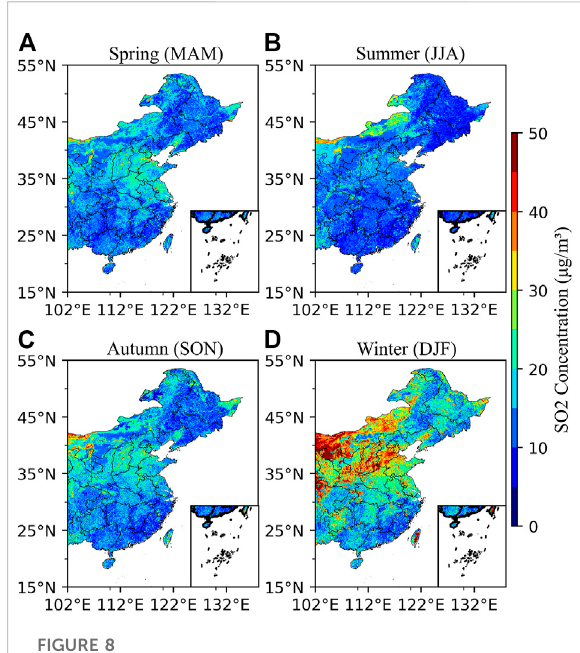
FIGURE 8 Spatial distribution of the seasonal mean of SO 2 predicted by the model ( μ g/m 3